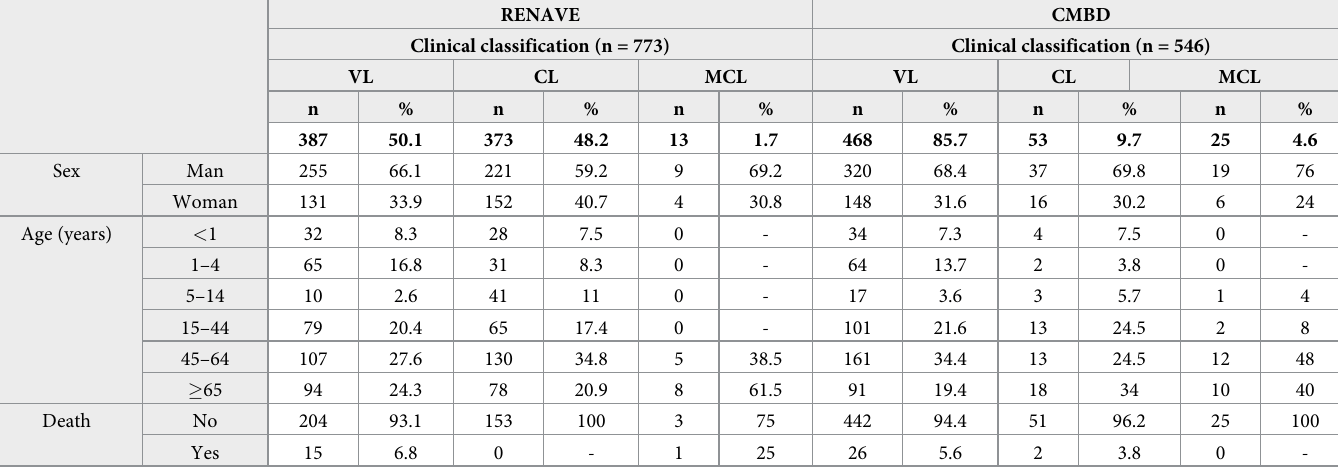
Table 2. Sociodemographic characteristics of leishmaniasis cases according to the data source, RENAVE and CMBD, Spain, 2016–2017.